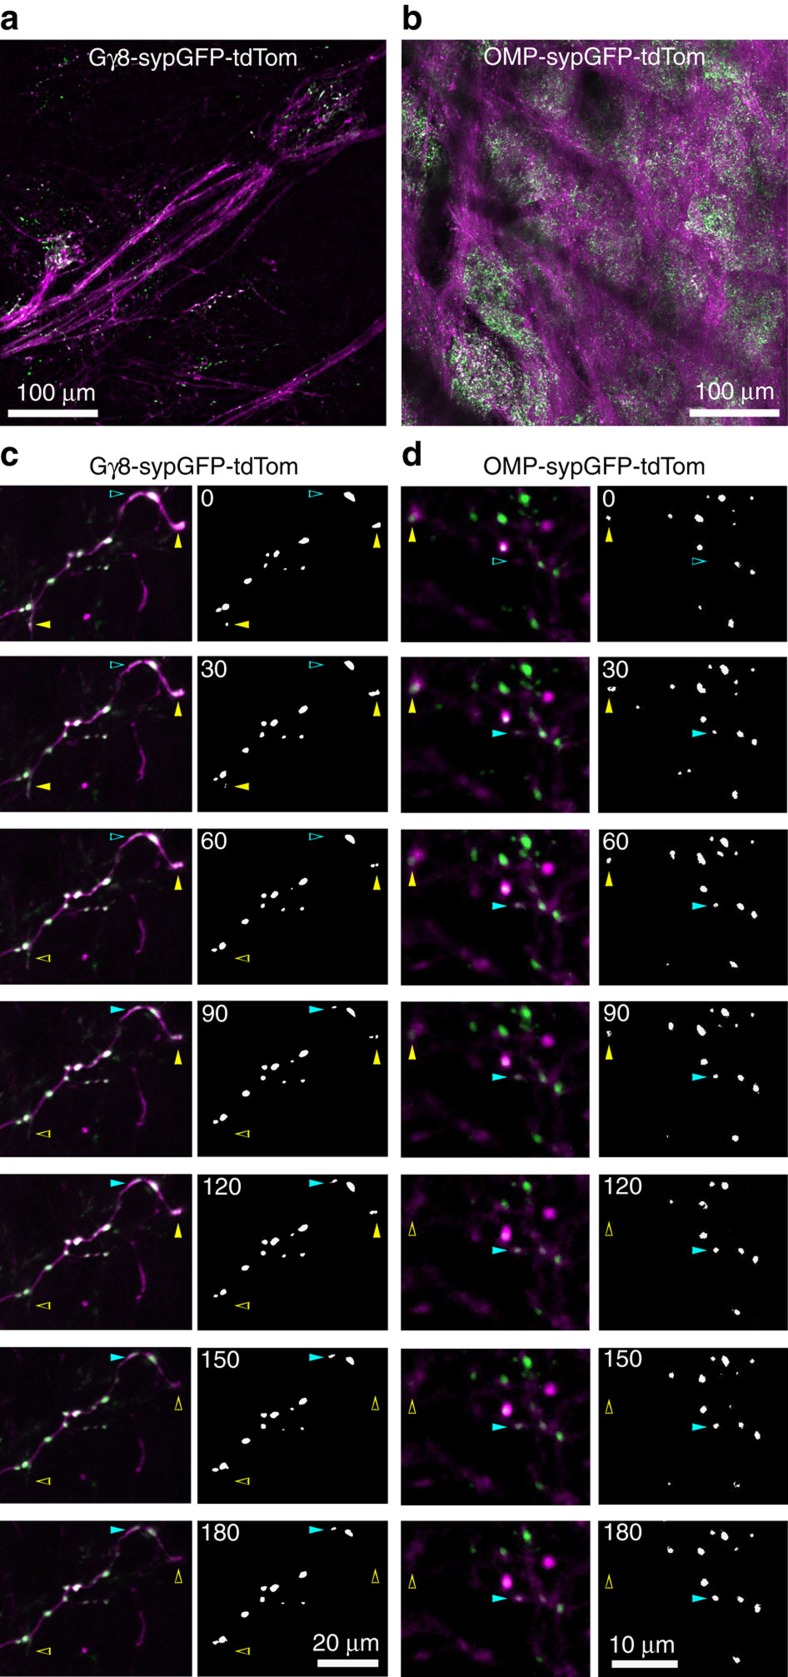
In vivo two-photon time-lapse imaging of OSN presynaptic terminals.(a,b) Maximum intensity projections of in vivo two-photon z-stacks showing the dorsal surface of the OB in 3-week-old Gγ8-sypGFP-tdTom (a) and OMP-sypGFP-tdTom (b) mice. (c) Maximum intensity projections of time-lapse images of an immature OSN axon. (d) Single optical sections of time-lapse images from an OMP-sypGFP-tdTom mouse. (c,d; left) Fluorescence images and (right) detected sypGFP puncta. Yellow arrowheads: puncta destined to be lost; cyan arrowheads: newly formed puncta.